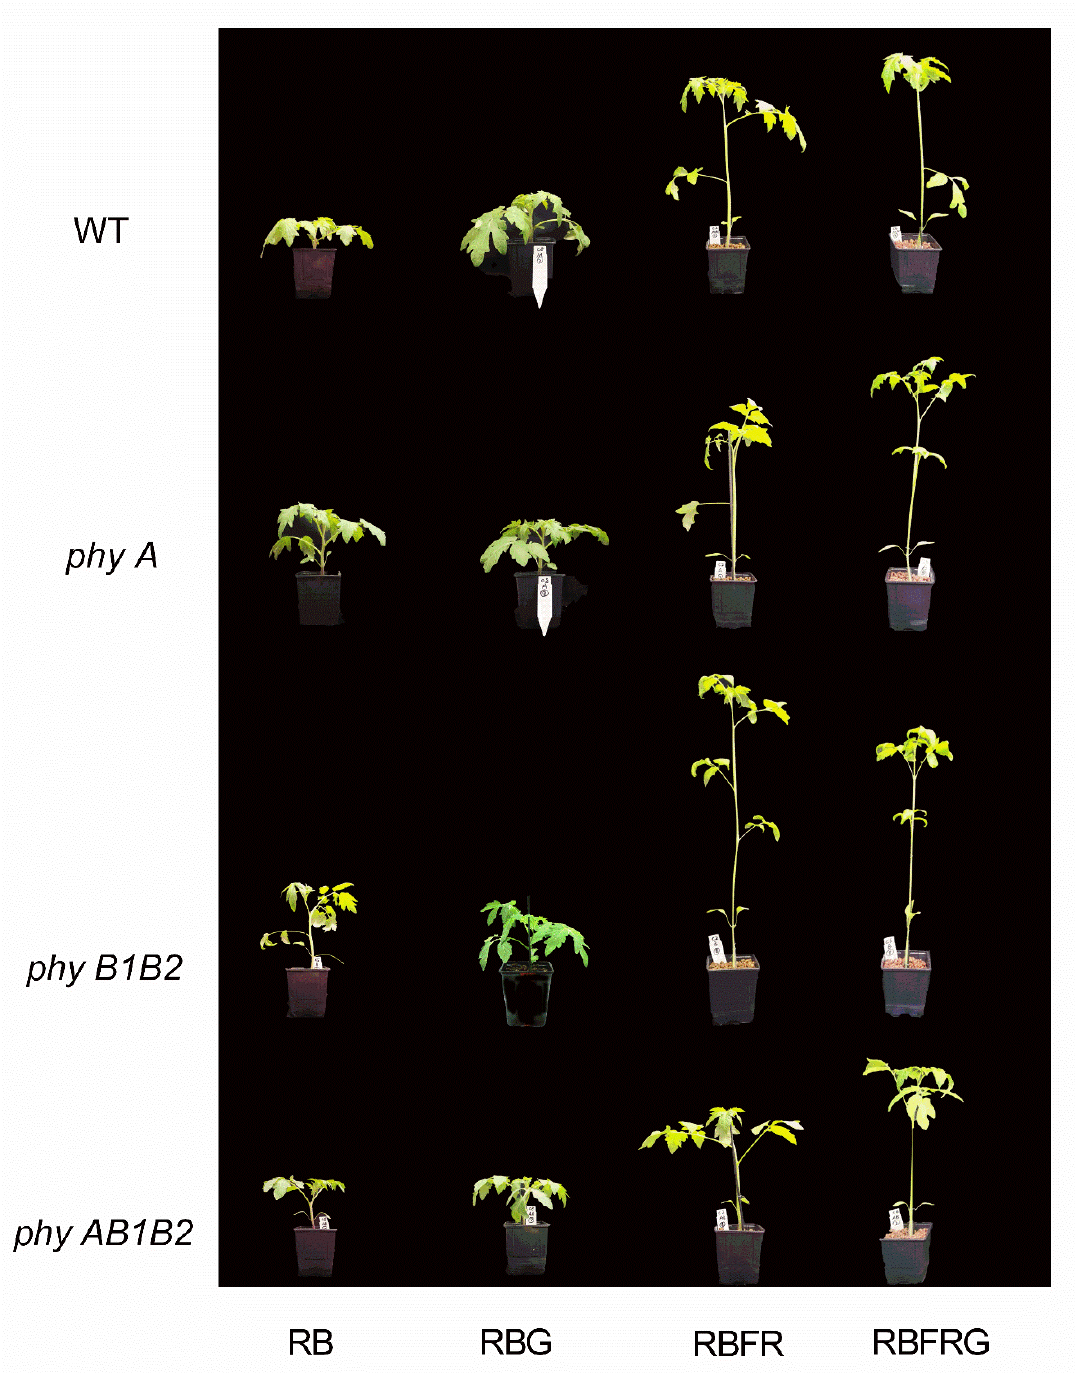
Figure 1. Representative pictures showing the effect of partial (20%) substitution of red/blue (RB; 3:1) with green (G) light in the presence or absence of far-red light (FR) on tomato phenotypes 21 days after treatment. Four genotypes were studied: WT (Moneymaker, wild-type), phyA (phytochrome A-deficient), phyB1B2 (phytochrome B1- and B2-deficient), and phyAB1B2 (phytochrome A-, B1-, and B2-deficient) (Exp1).